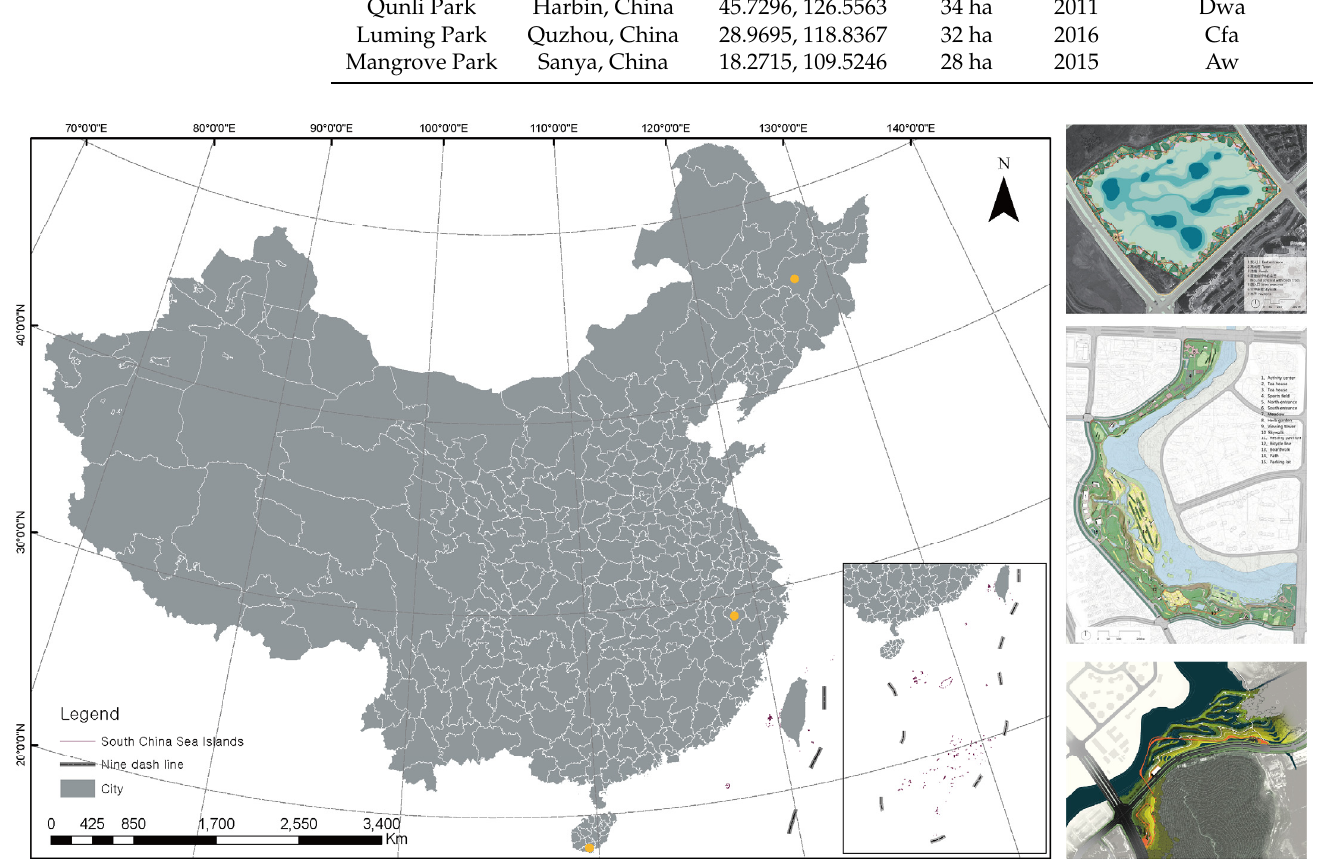
Figure 1. Study area. The order of the three study areas from top to bottom is Qunli Park, Luminous Park, and Mangrove Park. Source of pictures of the study area: https://www.turenscape.com (accessed on 24 January 2022).